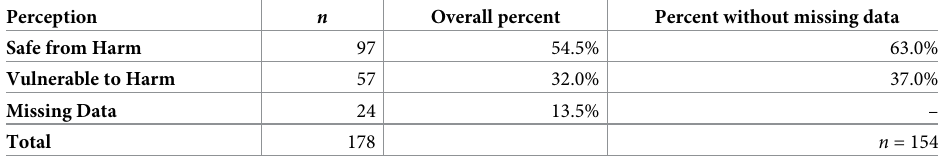
Table 4. Perception of personal risk of harm.